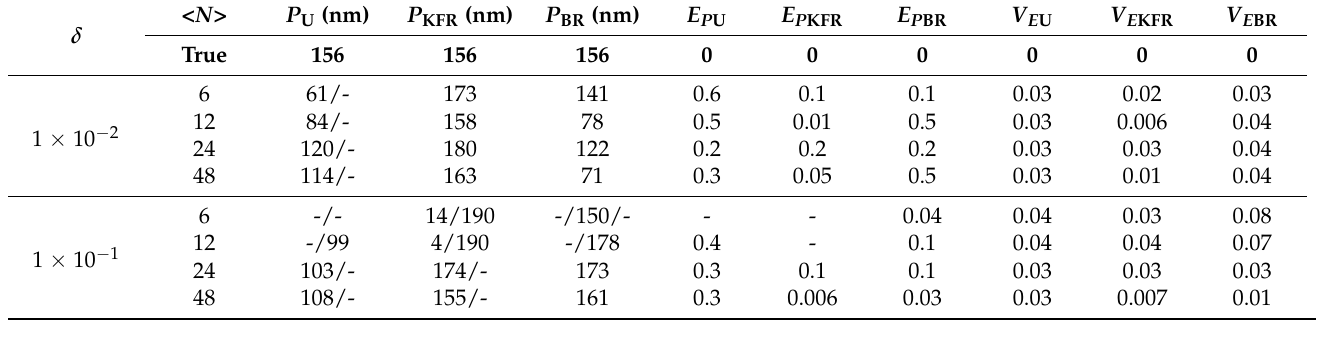
Figure 5. PSD recovered by the KFR method for a 156 nm unimodal sample at number concentrations of < N > = 6, 12, 24, 48, and different levels of noise. ( a ) 0, ( b ) 10 − 4 , ( c ) 10 − 3 , ( d ) 10 − 2 , and ( e ) 10 − 1 noise levels.